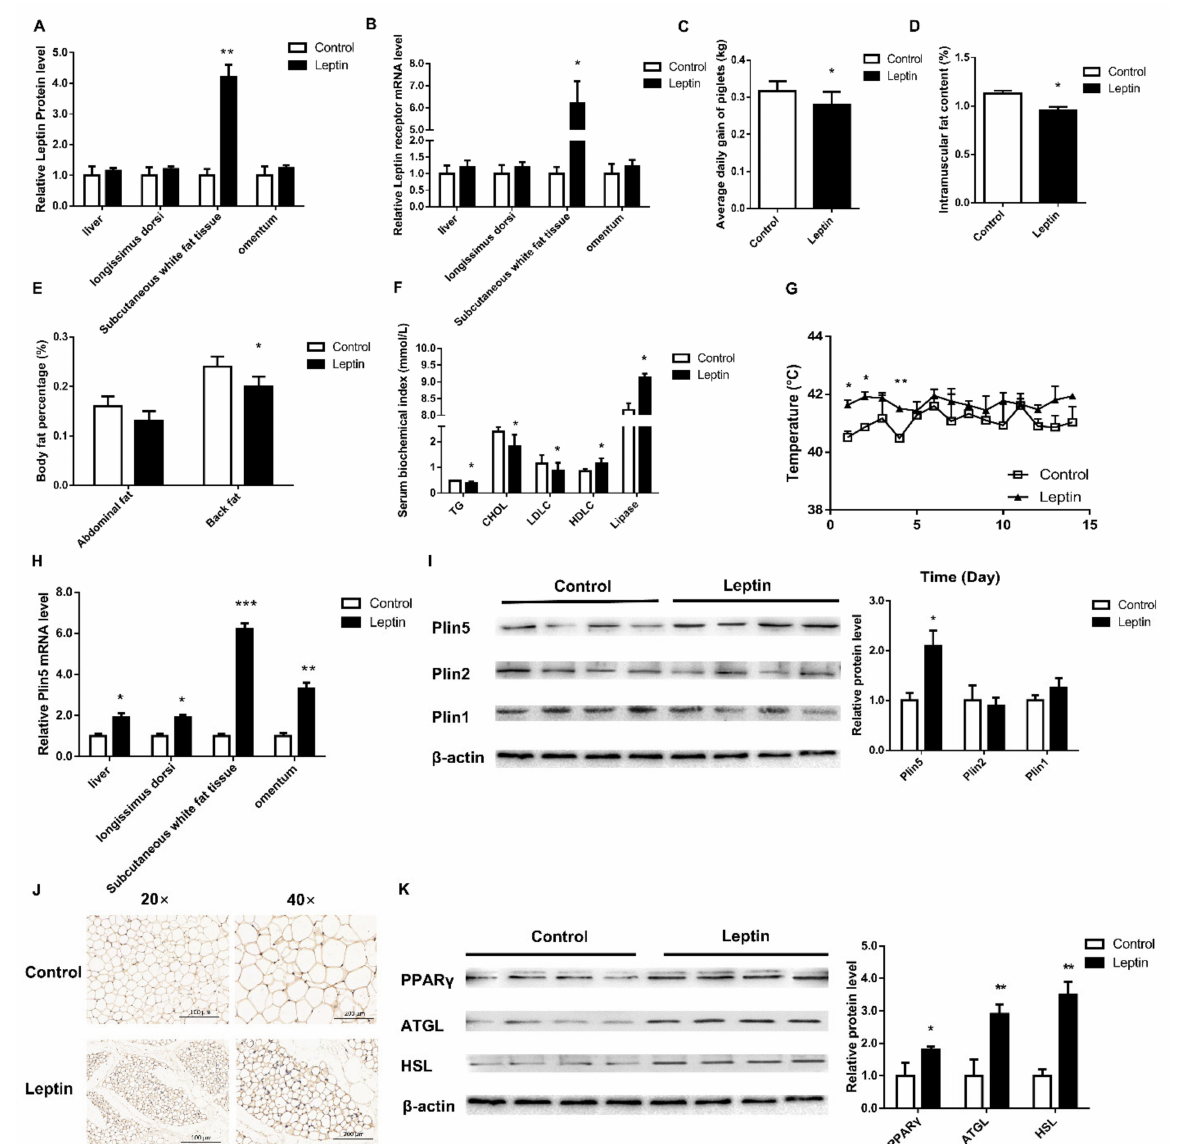
Figure 1. Leptin improves the body fat composition and weight of piglets by up-regulating the expression of Plin5. ( A ) The leptin kit was used to detect the level of leptin protein in various tissues of piglets. ( B ) The expression of leptin receptors in various tissues of piglets. The effect of leptin treatment on: ( C ) the average daily gain, ( D ) the intramuscular fat content, ( E ) abdominal fat rate and back fat rate and ( F ) blood lipid level etc. ( G ) The change of piglet’s body temperature for 15 days after leptin treatment. ( H , I ) The mRNA and protein expression levels of the Plin family were analyzed by real-time quantitative PCR and western blot. ( J ) Immunohistochemical detection of piglet adipose tissue. ( K ) Western blot analysis of lipolytic protein expression. n = 4 in each group, values are means ± SD. vs. control group, * p < 0.05, ** p < 0.01, *** p <